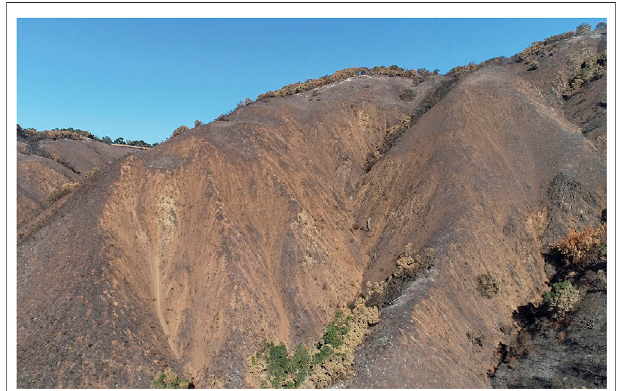
FIGURE 8 | Fifteen-minute duration precipitation intensity during the debris- fl owtriggeringstorm. Verticallinesbound thetimethatthedebris fl ows enter the view of the time-lapse cameras. Horizontal line indicates the threshold intensity predicted to produce debris fl ows (USGS